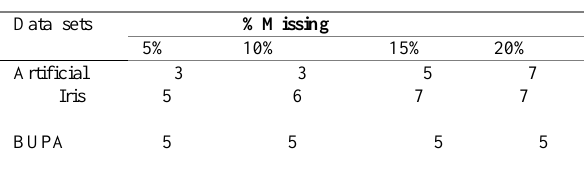
Table 2. Selected values for q.